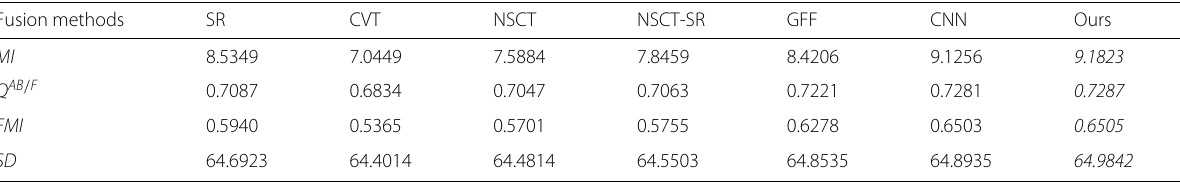
Table 2 Objective contrast of “Toy” Fusion